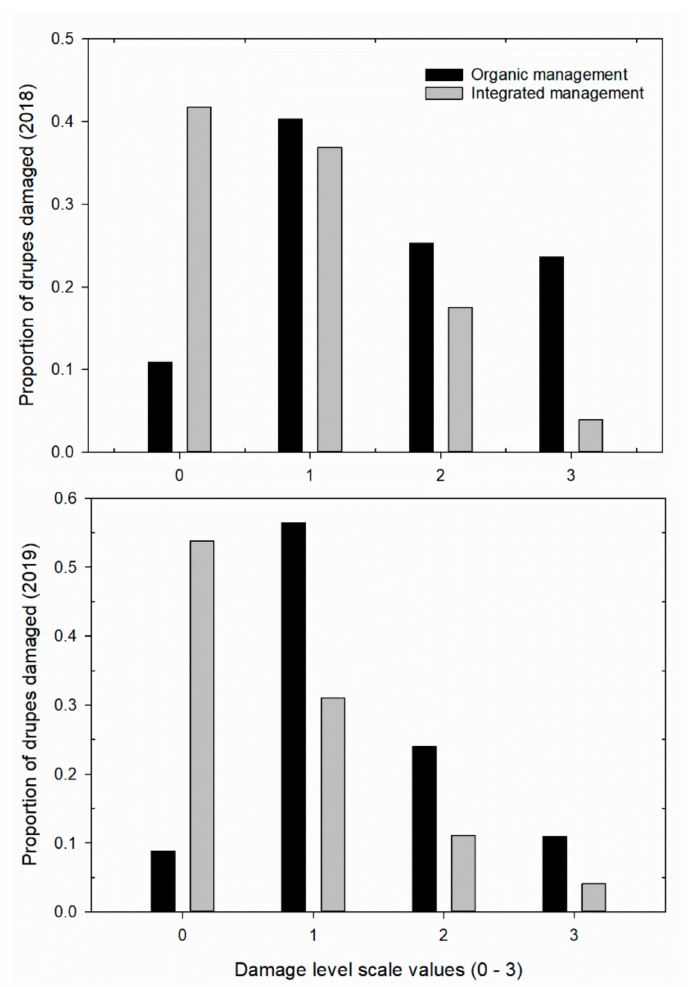
Figure 4. Proportion of drupes damaged by Liothrips oleae at di ff erent levels of damage with di ff erent types of phytosanitary management (see Figure 1c). Damage to drupes was evaluated using a scale of 0 to 3 according to the number of necrotized stings (see Material and Methods).